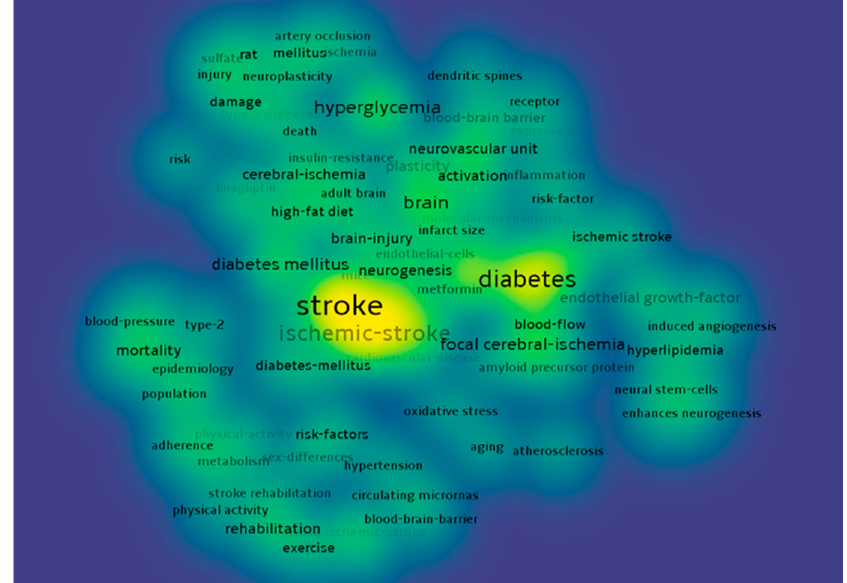
Figure 4. Keyword density map.